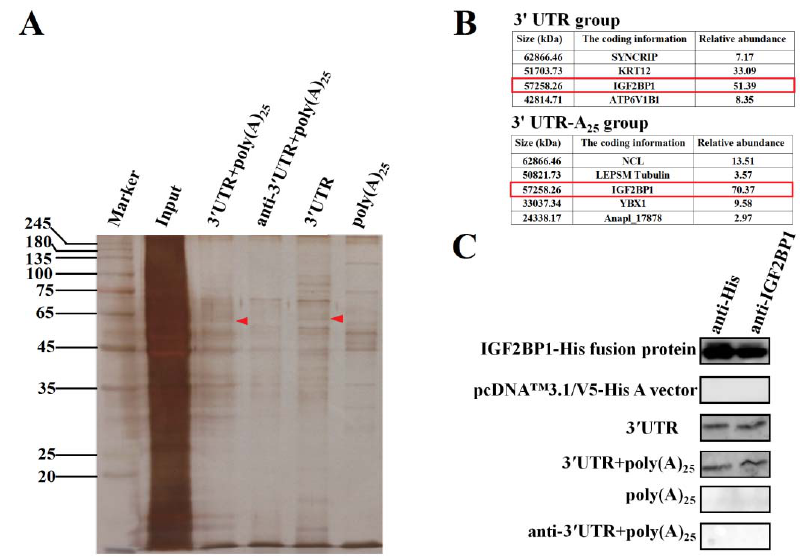
Figure 2. Insulin ‐ like growth factor ‐ 2 mRNA ‐ binding protein ‐ 1 (IGF2BP1) specifically binds to the 3 ′ untranslated region (UTR) of duck hepatitis A virus type 1 (DHAV ‐ 1). ( A ) Silver ‐